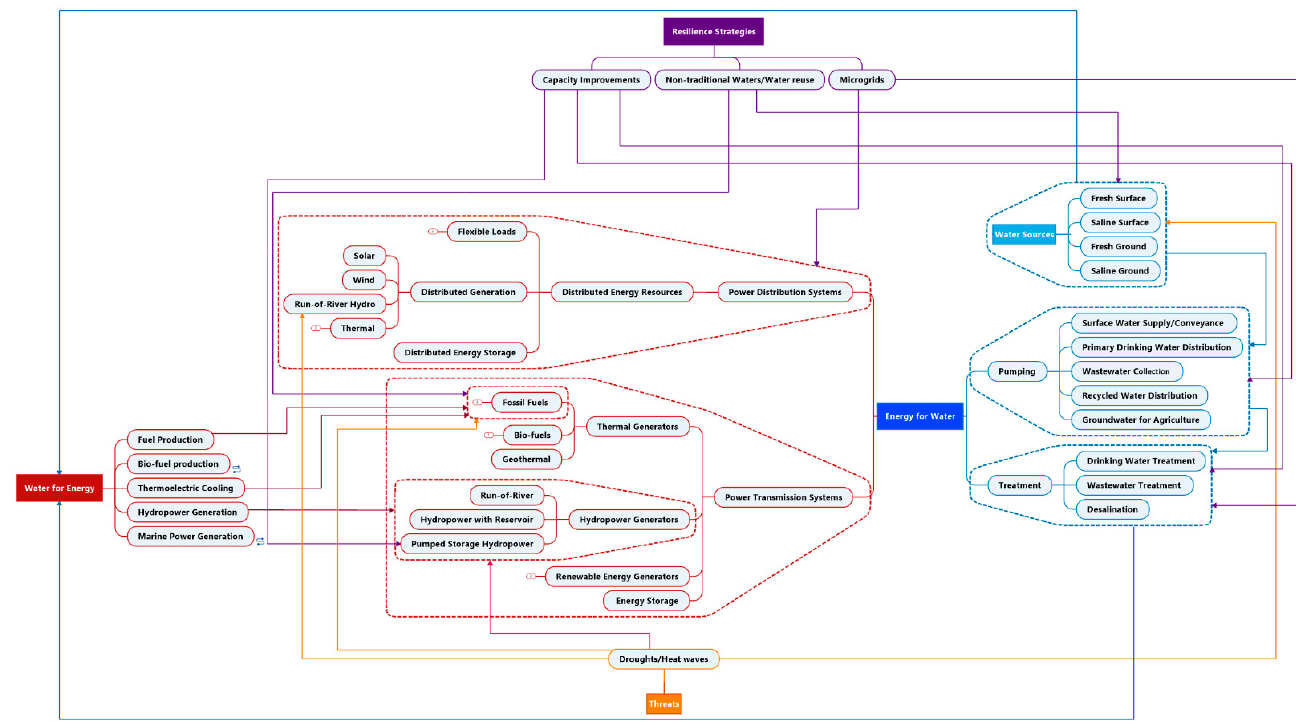
Figure 4. Visualization example of co-managed WPS opportunities and threats. Water-power microgrids are another co-managed resilience strategy of interest. Water-power microgrids are small-scale interdependent water and power distribution systems that can selectively disconnect from the main power grid during a disruptive event and operate autonomously without affecting the reliable supply of electricity and water. To enable this autonomous operation, water-power microgrids use dispatchable distrib- uted energy resources (i.e., solar units, small wind turbines, battery storage, combined heat and power generators, diesel generators, run-of-river hydro, flexible demand loads, etc.) that provide independent power to designated critical loads, including pumping loads, and sectionalized switchers that disconnect and reconnect the microgrids from the main grid. Water-power microgrids can be co-managed by water and power operators through a central controller that monitors water and power system operating parameters (e.g., voltages, water/power flows, head pressure, etc.), balances power/water supply and demand, and enforces the transition between autonomous and interconnected mode dur- ing power grid outages. Although the concept of water-power microgrids has been thor- oughly studied [62–64], their actual implementation is still at the experimental level. While "win-win," co-managed resilience strategies for WPS appear feasible, several challenges hinder collaboration, such as understanding the probability of extreme events, funding of joint mitigation strategies, and the fair allocation of operational and investment costs of these mitigation strategies across water and power utilities. Indeed, lack of cost- benefit valuation data and shared systems understanding can inhibit the allocation of costs and create difficulties when accounting for cross-sector benefits. This can be espe- cially troublesome in communities that face high poverty levels when rates need to be increased to fund resilience investments. Although federal funding is available post-dis- aster, federal support funds are not typically available to pro-actively fund resilience in- vestments. The complete visualization prototype that contains all potential combinations of co- managed resilience strategies between interdependent WPS when impacted by different hazard threats can be found in Figure S1 of the Supplementary Materials.